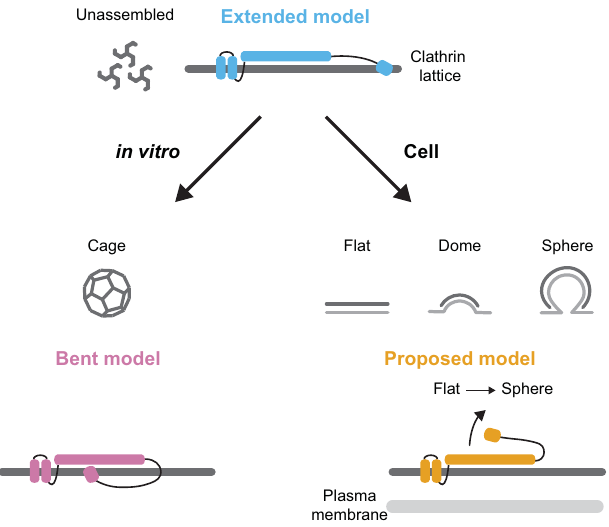
Fig.6|ModelsofconformationalswitchinCLCinlivingcells. Schematicmodels of conformationalswitchin CLCatthe plasma membrane incells. CLC assumes an extended conformation in unassembled triskelia in the cytoplasm similar to that seeninx-raycrystalstructures.Next,whenCLCassemblesatthemembraneasa fl at lattice, CLC changes conformations from the extended to a new folded con- formation. The N-terminus is then displaced deeper into the cytosol as clathrin